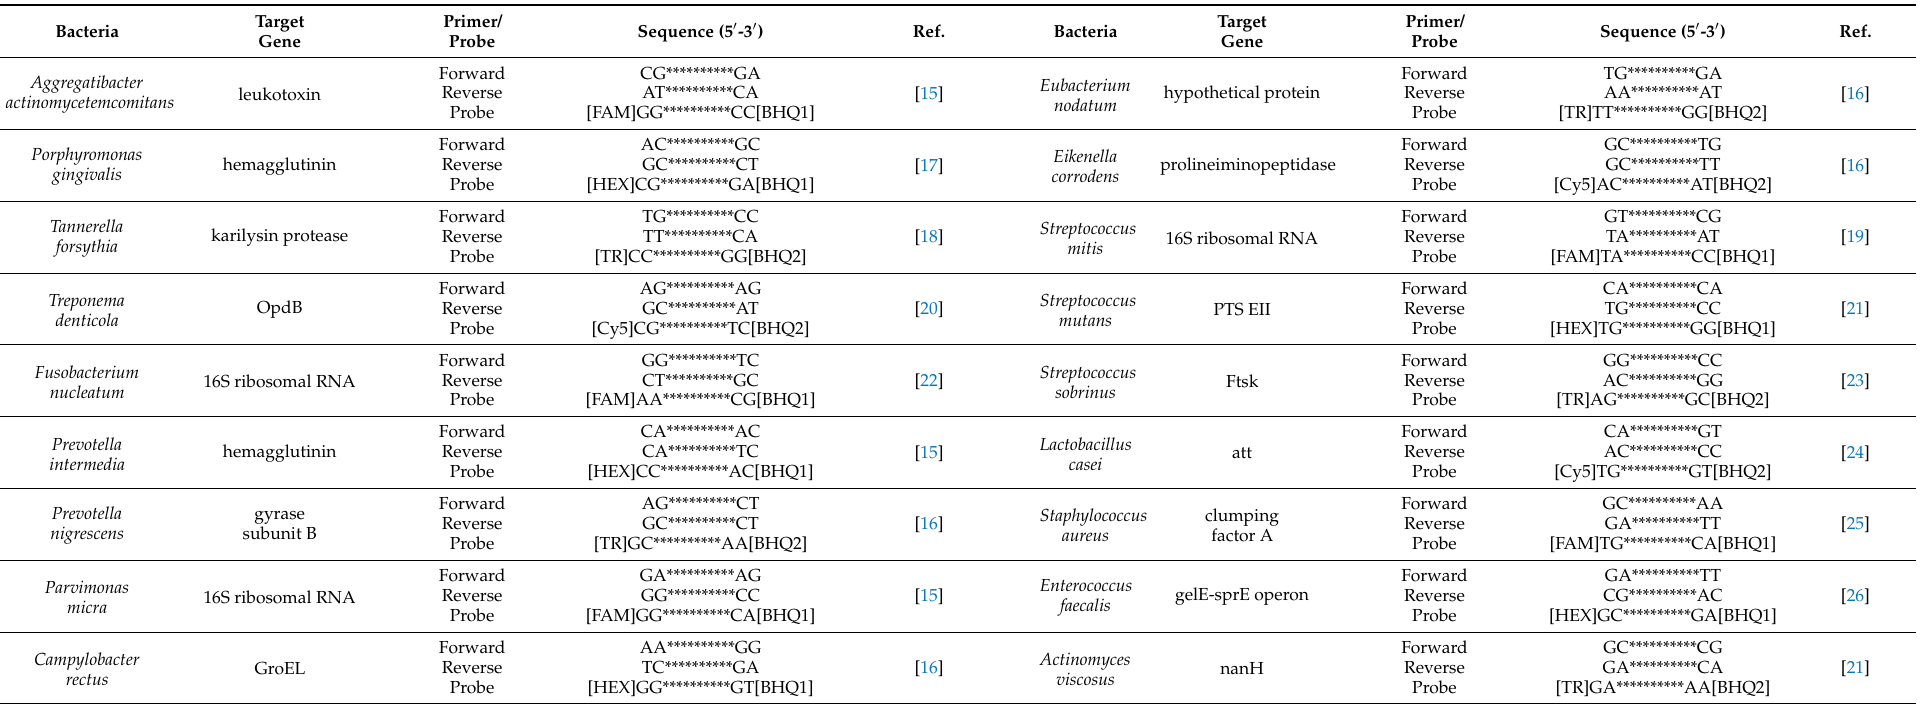
Table 1. Primers and probes of the 18 species of bacteria